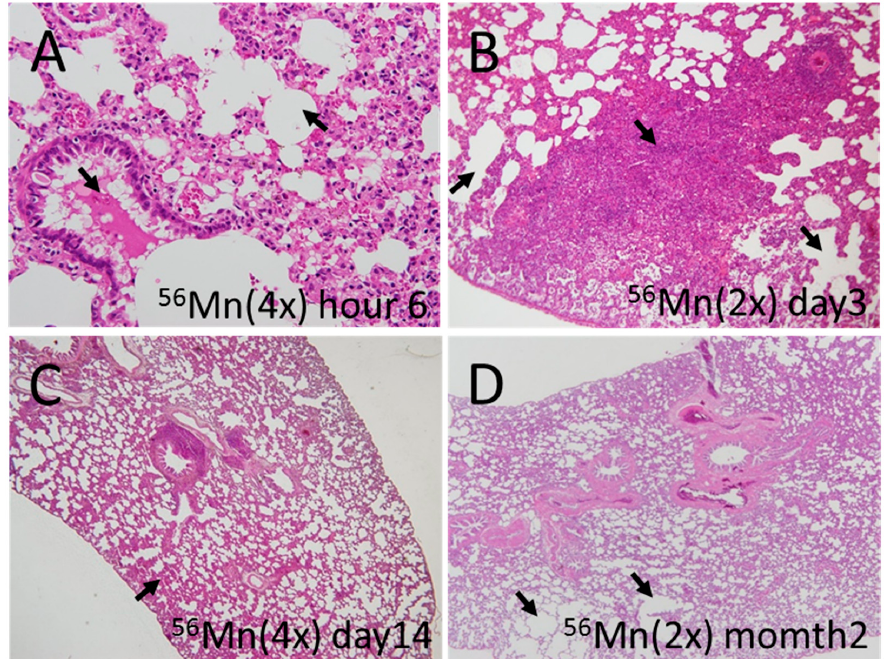
Figure 1. Representative fields of lung tissue early histology collected from 56 Mn exposed rats. ( A ) 56 Mn(4 × ) radiation collected at 6 h post-irradiation. Arrows indicate severe hemorrhage and emphysema; ( B ) 56 Mn(2 × ) radiation collected at day 3 post-irradiation. Arrows indicate severe atelectasis and emphysema; ( C ) 56 Mn(4 × ) radiation collected at day 14 post-irradiation. Arrow indicate moderate hemorrhage; ( D ) 56 Mn(2 × ) radiation collected at month 2 post-irradiation. Arrows indicate severe emphysema. H&E stain, A: 40 × , B: 10 × , C, D: 4 × objective magnification.